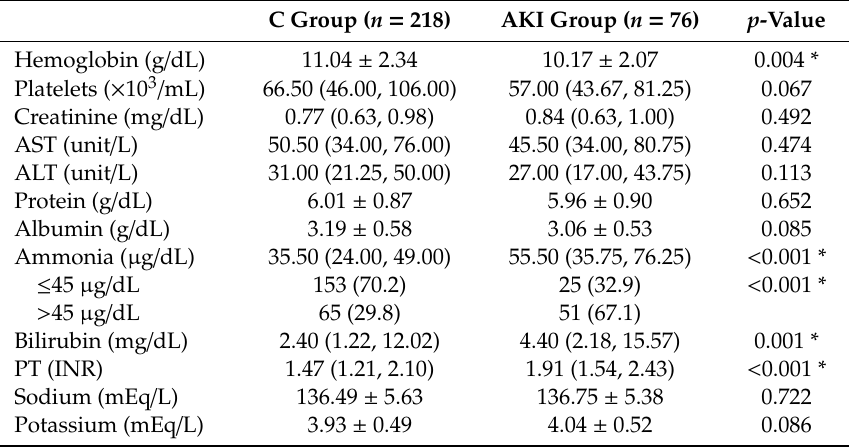
Table 2. Preoperative laboratory data of patients undergoing liver